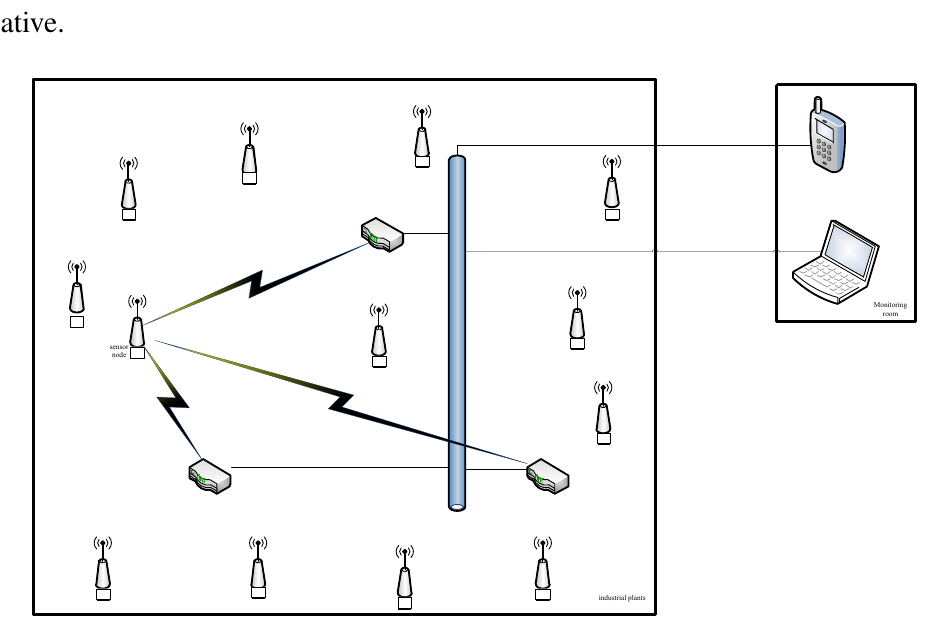
Figure 6. Architecture of the wireless sensor networks